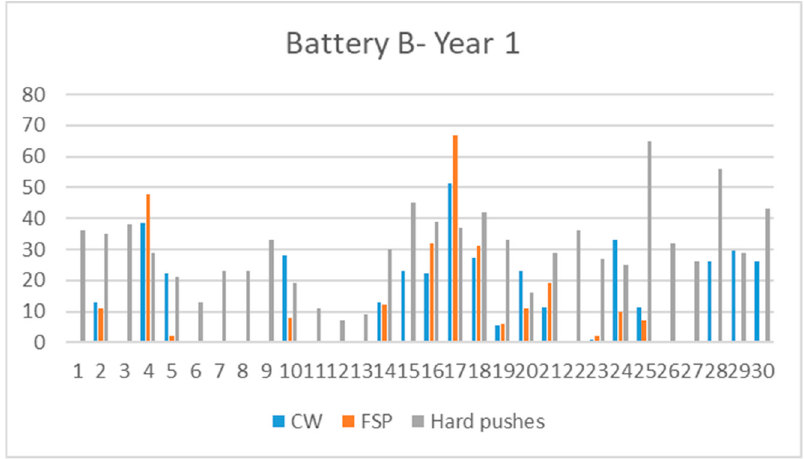
Figure 10. Hard pushes and refractory repairs battery B, year 1.